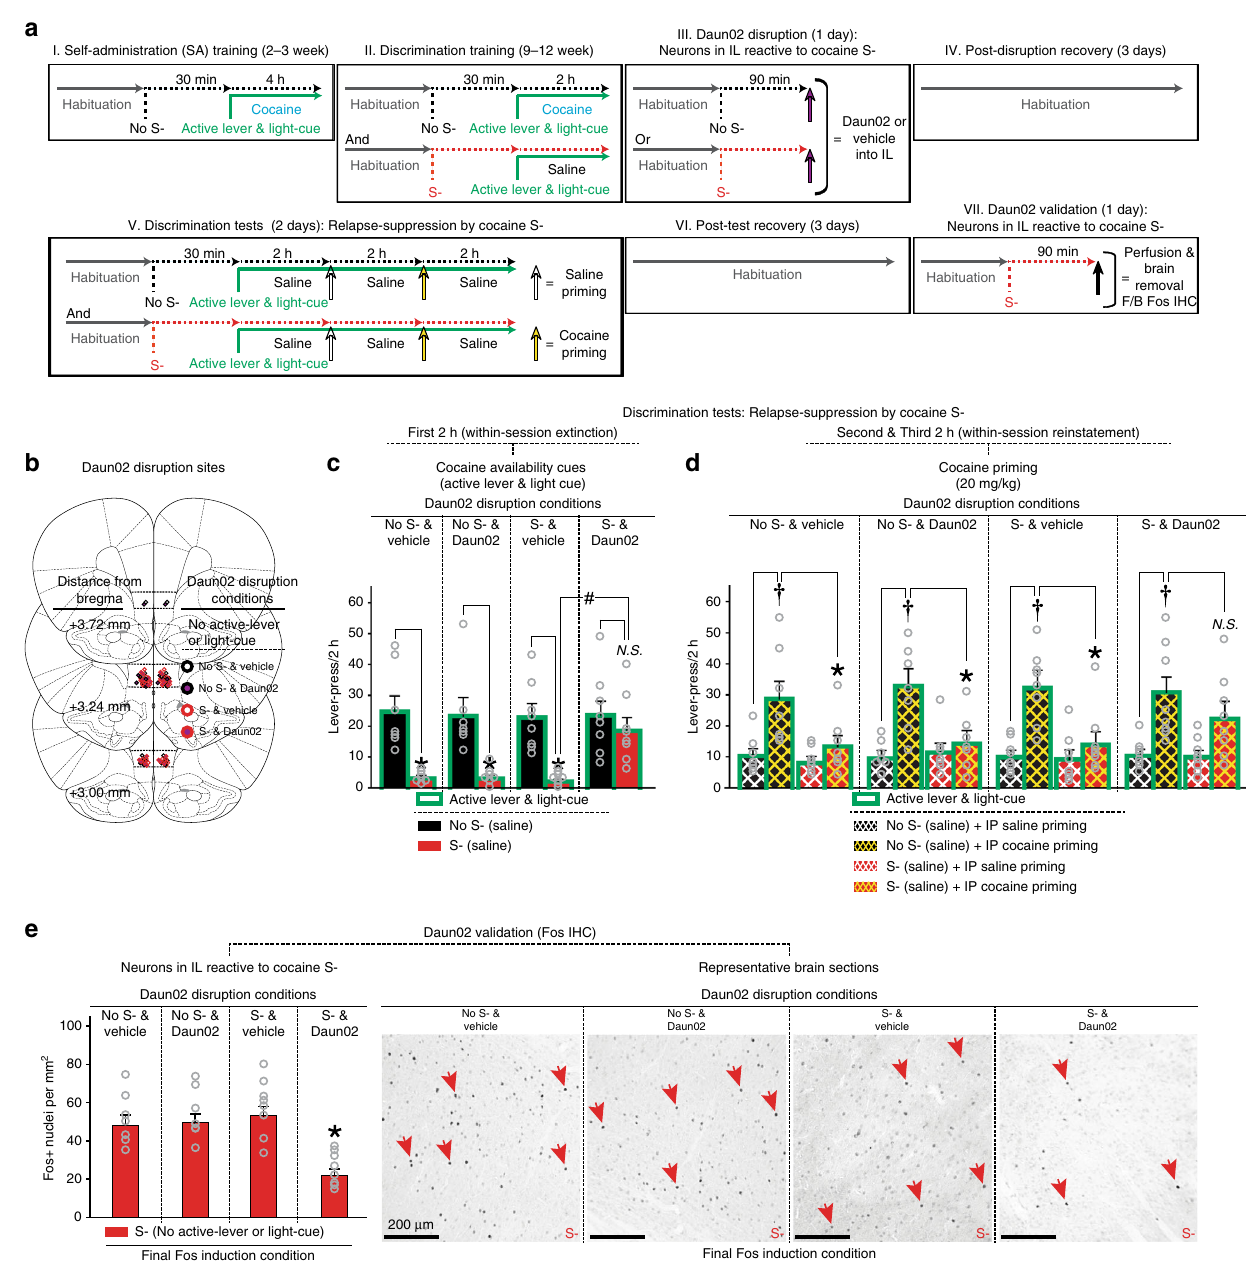
Fig. 4 Omission cue-induced suppression (OCIS) procedures for functional characterization of omission cue-activated neurons via activity-based Daun02 disruption. All data are mean and SEM. Gray open circles on bar charts depict individual data-points. Tukey HSD test was used for all post-hoc analyses. a Timeline and schedule. b Daun02 disruption sites (line drawings adapted from Paxinos and Watson 81 with permission). c Responses during the fi rst 2-h block of Discrimination test to determine cocaine S- ‘ s action against cocaine availability cues. n = 7,7,8,8. Two-way mixed ANOVA: Cue-Test ( F (1,26) = 37.70, P < 0.01) main effects and Group x Cue-Test interaction ( F (3,26) = 3.49, P < 0.05). *P < 0.001 vs. No S-. #P < 0.05. d Responses during the second and third 2-h blocks of Discrimination test to determine anti-relapse action of cocaine S- against cocaine priming. Two-way repeated measures ANOVA was separately conducted for each group. “ No S- & vehicle ” group ( n = 7): Priming ( F (1,6) = 7.50, P < 0.05) main effects and Cue-Test x Priming interaction ( F (1,6) = 12.88, P < 0.05). “ No S- & Daun02 ” group ( n = 7): Cue-Test ( F (1,6) = 8.04, P < 0.05) and Priming ( F (1,6) = 25.53, P < 0.01) main effects, and Cue- Test x Priming interaction ( F (1,6) = 11.27, P < 0.05). “ S- & vehicle ” group ( n = 8): Priming ( F (1,7) = 21.91, P < 0.01) main effects and Cue-Test x Priming interaction ( F (1,7) = 17.31, P < 0.01). “ S- & Daun02 ” group: Priming ( F (1,7) = 19.50, P < 0.01) main effects but not Cue-Test ( F (1,7) = 3.84, NS) or Cue-Test x Priming interaction ( F (1,7) = 1.71, NS). † P < 0.001 vs. saline. * P < 0.01 – 0.05 vs. No S-. e Daun02 validation via Fos IHC. n = 7,7,8,8. One-way